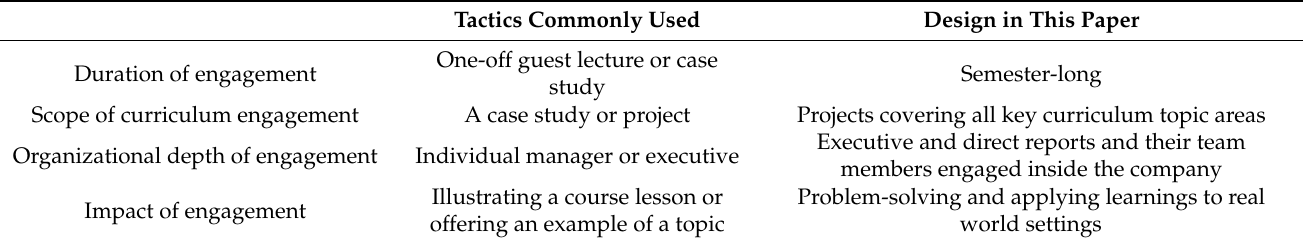
Table 2. Advancing education-focused engaged